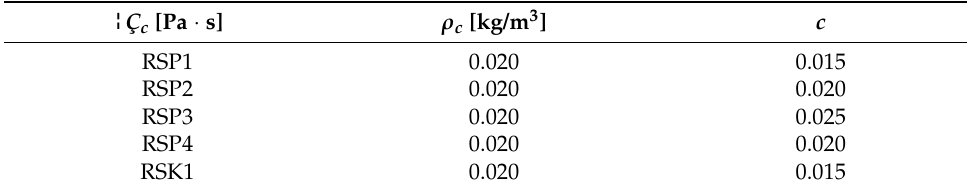
Figure 15. Diagram of the dependence of spray angle on GLR determined with a classical bubble atomizer and its modifications [118]. The situation is different in the case of atomizer II, where a downward trend in the size of the spray angle with the increase in GLR value can be observed. The downward nature of the dependence curve α on GLR was also observed in the case of an effervescent atomizer without a swirl insert, where at GLR ≈ 0 the atomizer produced an angle of ap- proximately 0°. In turn, for GLR = 0.1, the maximum spray angle value was obtained, which was 40°. It is also worth emphasizing that the research showed that the sprayed liquid stream took the form of a hollow cone.